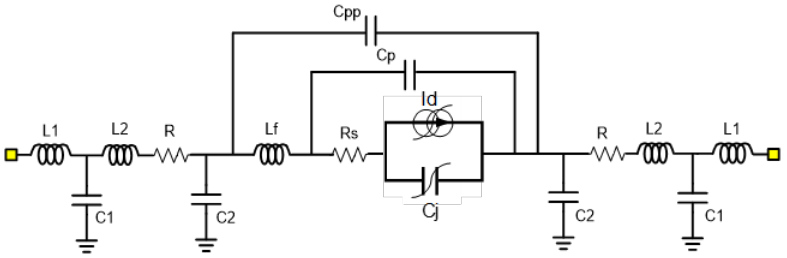
Figure 8. Equivalent circuit model of the diode, including the extrinsic elements.